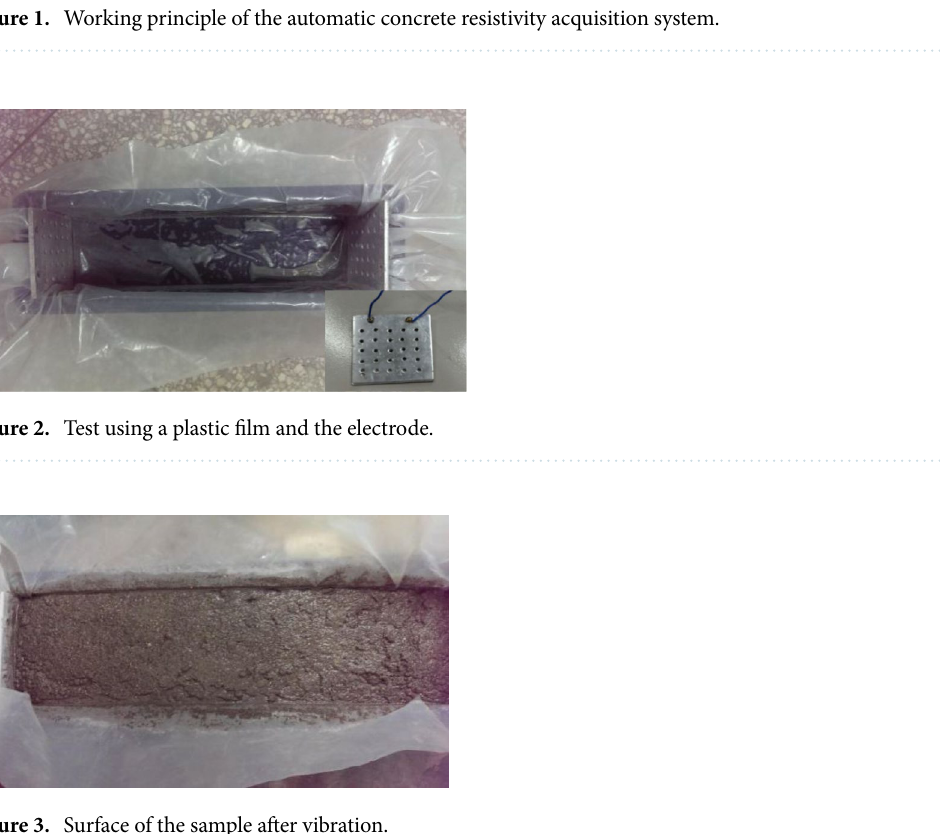
Figure 3. Surface of the sample after